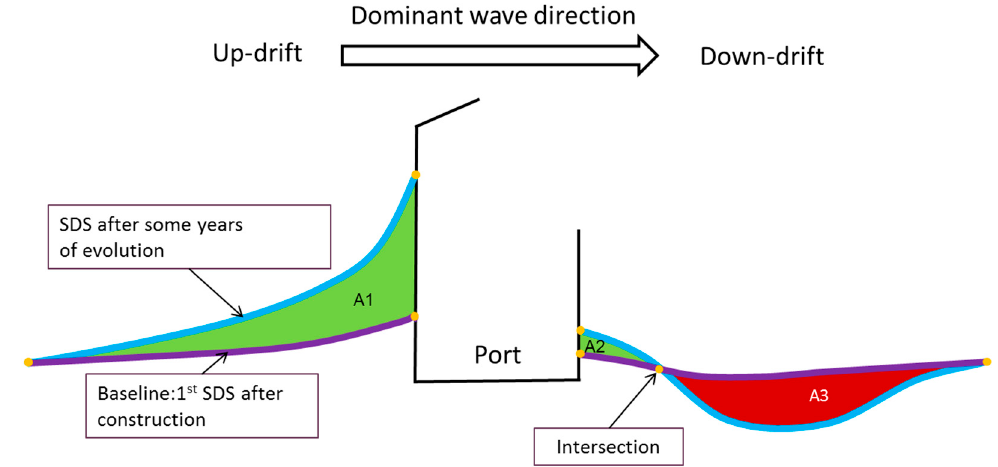
Figure 3. Schematic example of the up-drift and down-drift beach evolution adjacent to a port with shore-normal breakwater structures. The satellite derived shoreline (SDS) after several years of evolution (in blue) is compared to the baseline (in purple). Beach accretion is indicated by the green surface areas ( A1 and A2 ), whereas beach erosion is indicated by the red surface area ( A3 ). The orange dots indicate the intersections of the shorelines with each other, the up-drift and down-drift boundaries, and the port structures.